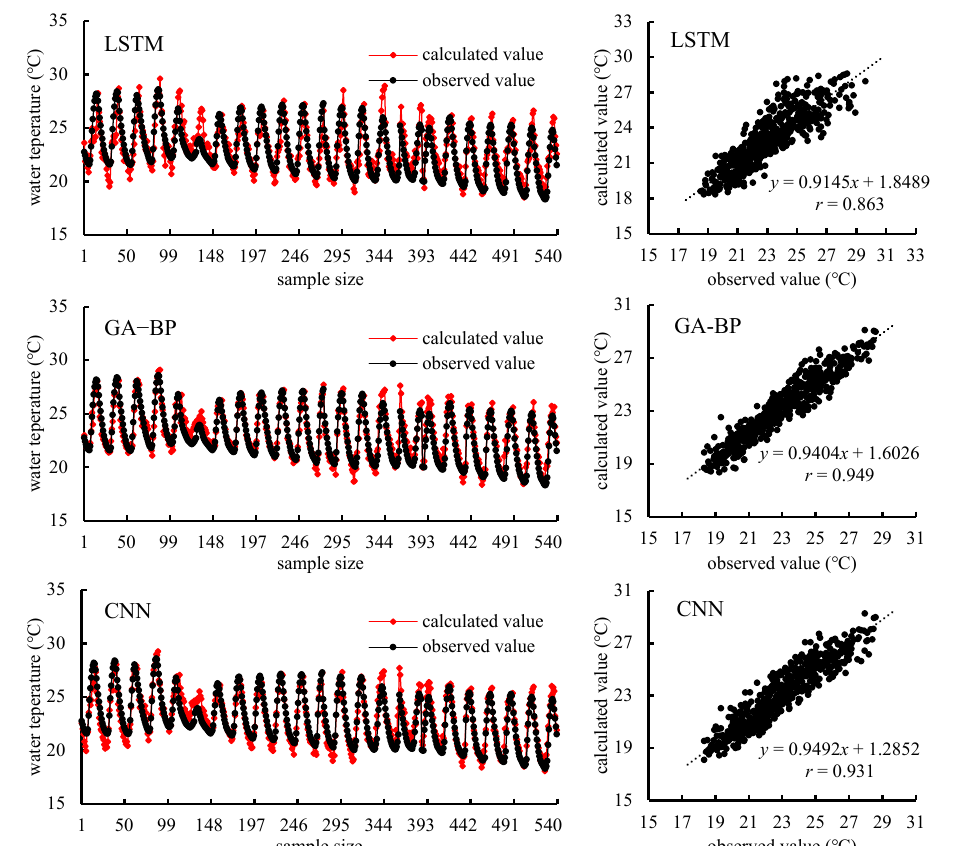
Figure 5. Dynamic curve and relationship between observed value and calculated value of hourly water temperature.